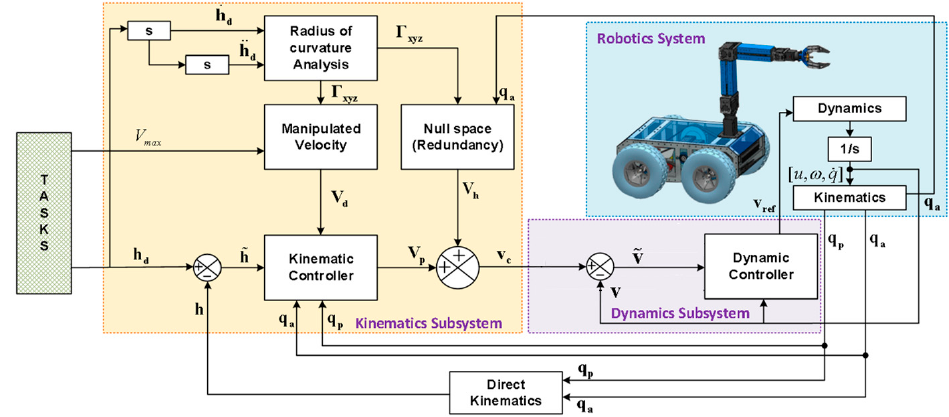
Figure 1. Block diagram of the motion control problems of mobile manipulators.